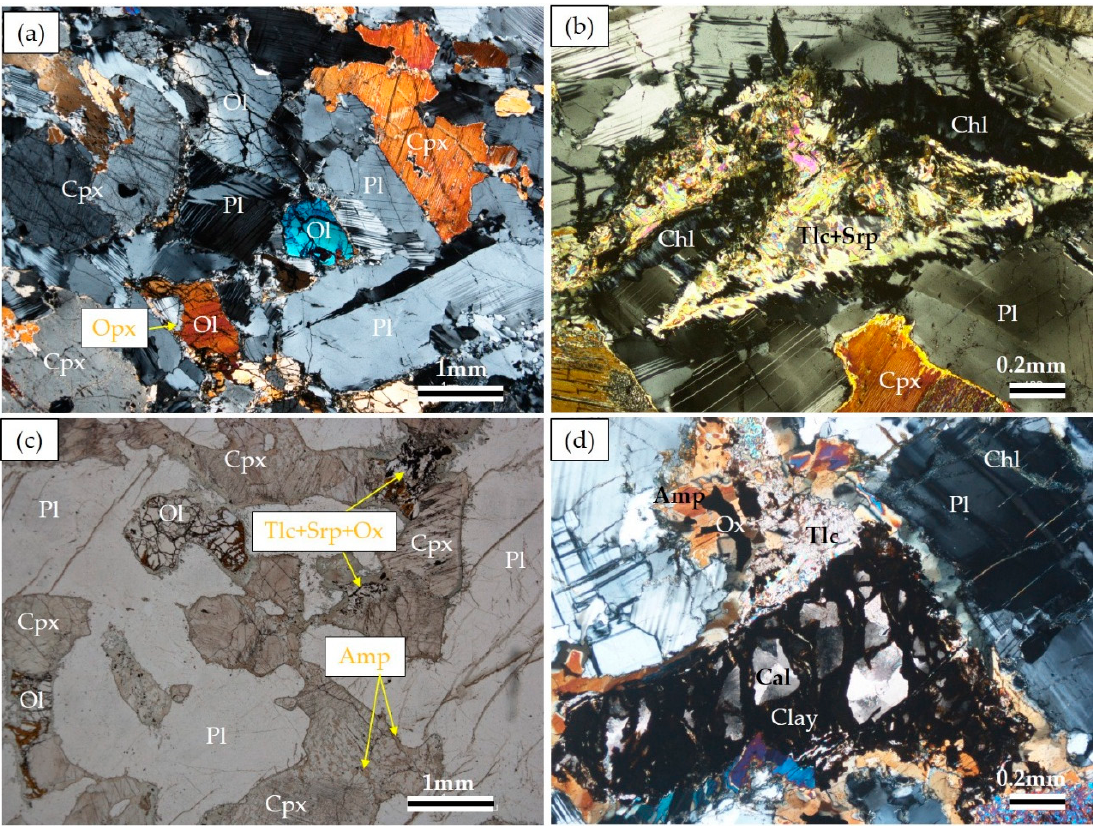
Figure 2. Photomicrographs of the host olivine gabbro IODP Hole U1473A. ( a , b ) Sample 66R5, 1–7 cm; orthopyroxene occurs as a thin rim between olivine and plagioclase; olivine is completely replaced by talc and serpentine, plagioclase is replaced by chlorite; ( c ) Sample 68R4, 121–124 cm; clinopyroxene grains include small (30–150 µm) blebs of brown amphibole. ( d ) Sample 41R2, 26–31 cm; Calcite pseudomorphing olivine. Ol: Olivine. Pl: Plagioclase. Cpx: Clinopyroxene. Opx: Orthopyroxene. Amp: Amphibole. Tlc: Talc. Srp: Serpentine. Cal: Calcite. Chl: Chlorite. Ox: Fe–Ti oxide.